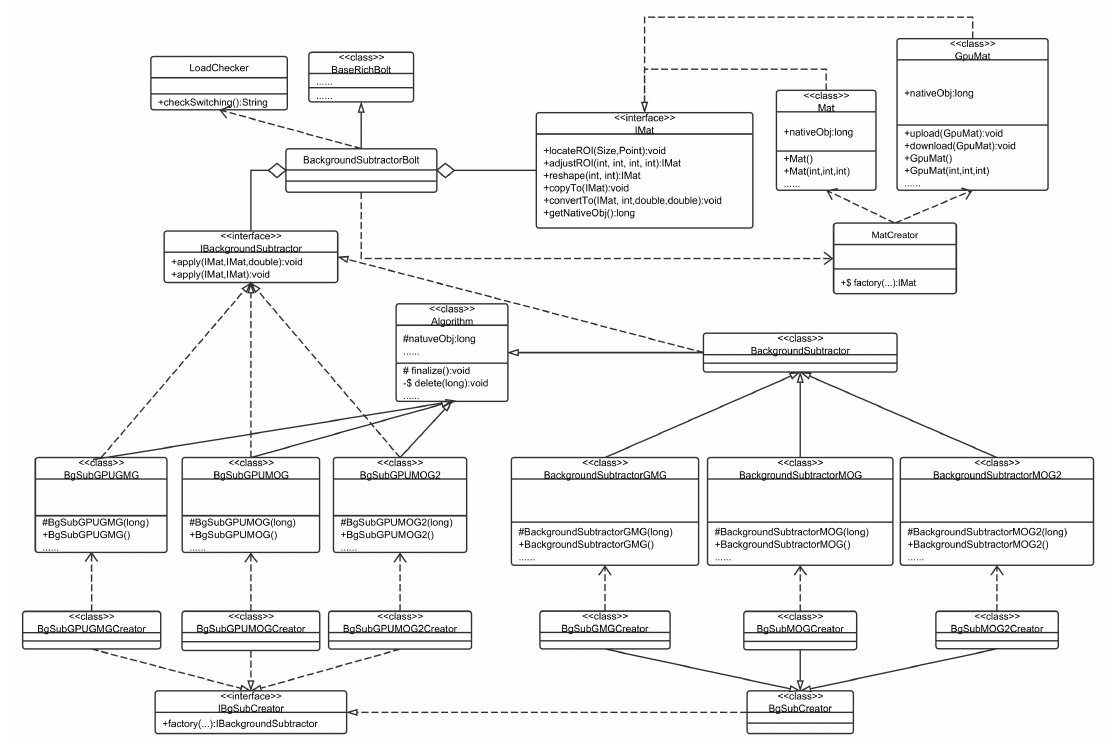
Figure 8. CPU-GPU switching architecture illustrated with background